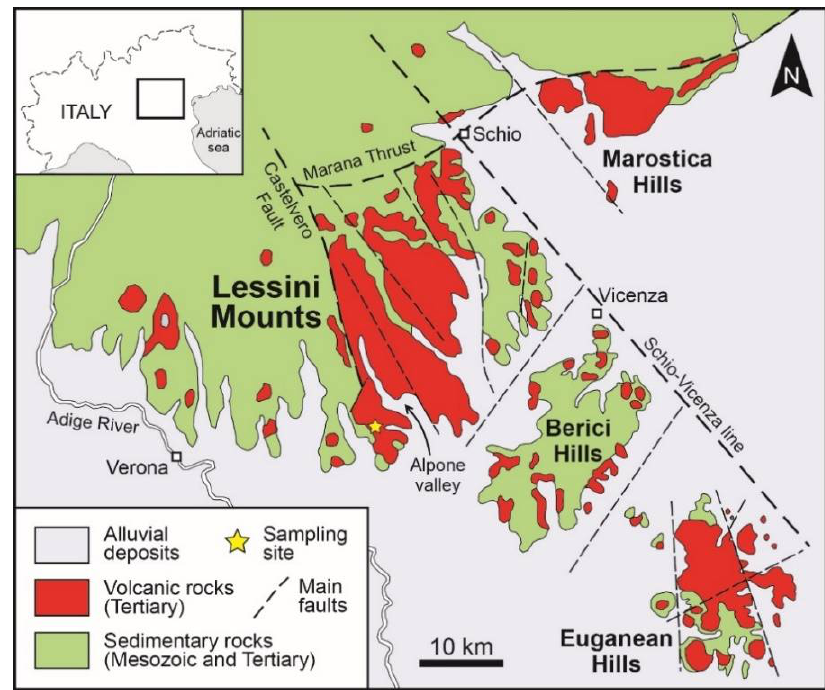
Figure 1. Simplified geological map of the Veneto Volcanic Province (modified from de Vecchi et al. [20]) showing the Lessini Mounts and the locations of the sampling site.